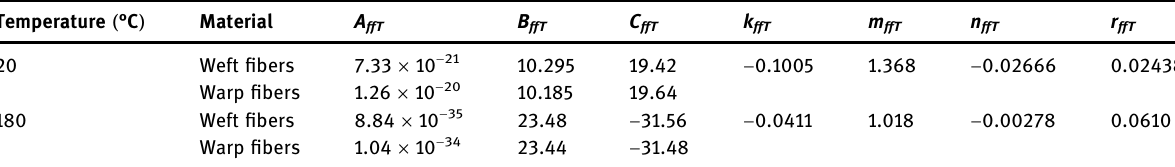
Table 4: Unknown parameters of the yarn fi ber damage evolution equation Temperature ( °C